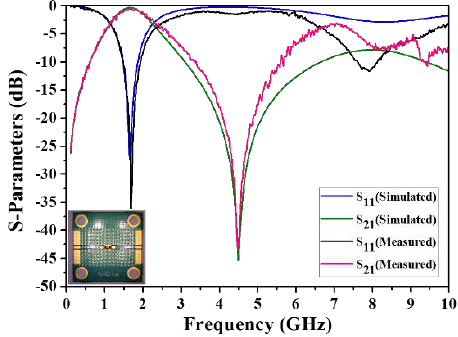
Figure 7. Simulated and measured results for the proposed BPF. Table 5. Comparison of IPD BPF performance.